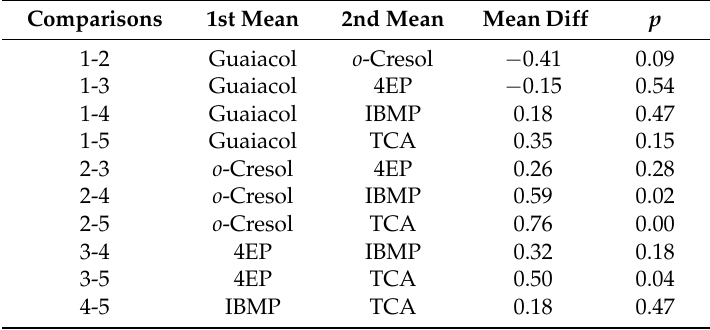
Table 3. Least Significant Difference comparisons between compound